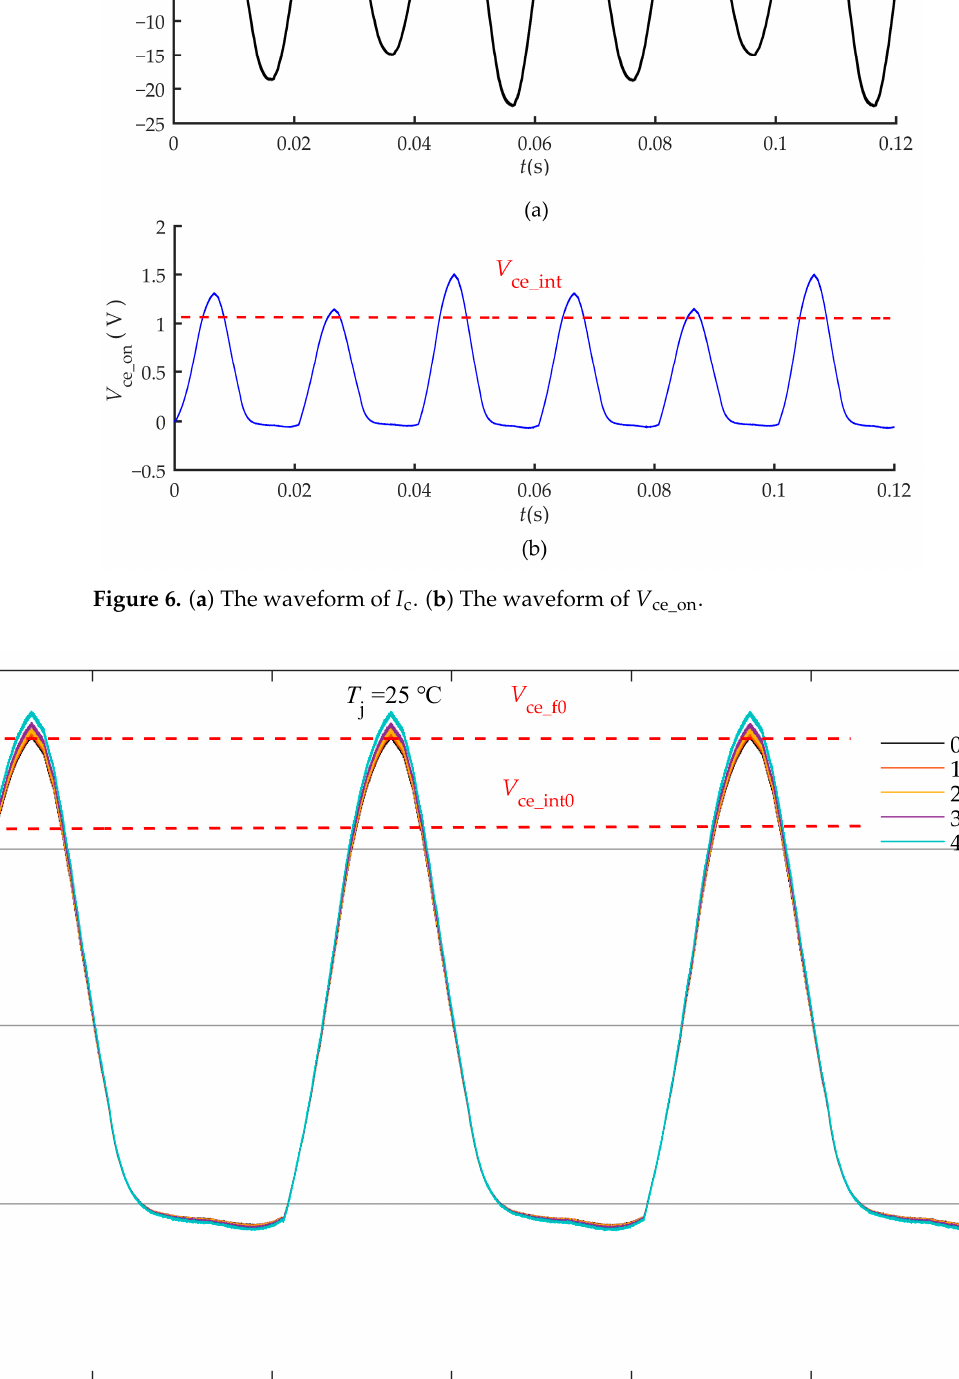
Table 3. Aging threshold.